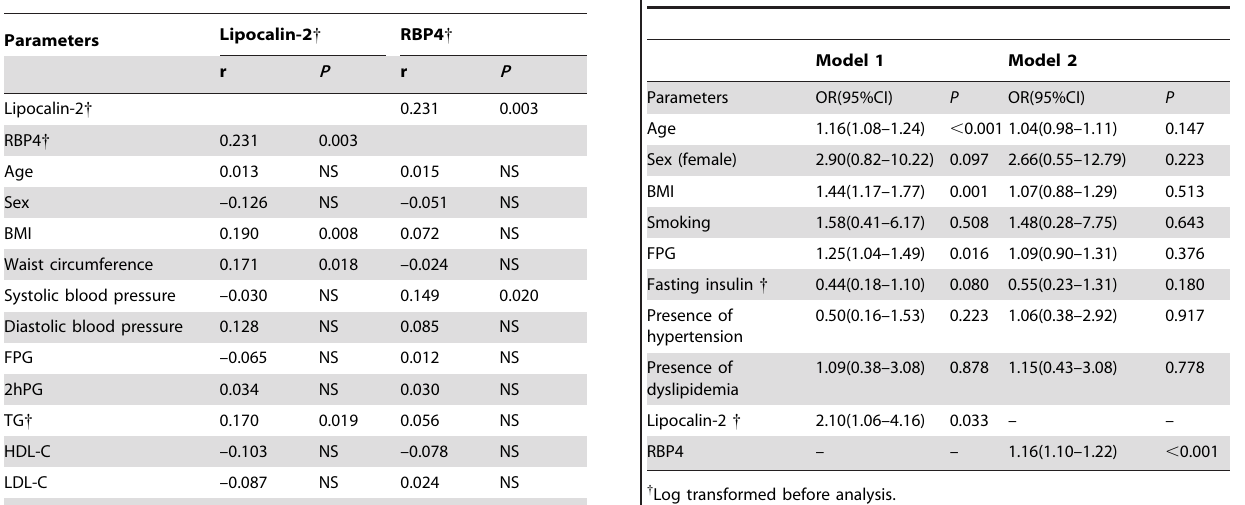
Table 3. Multiple logistic regression analysis showing the parameters with significant independent associations with subclinical atherosclerosis in type 2